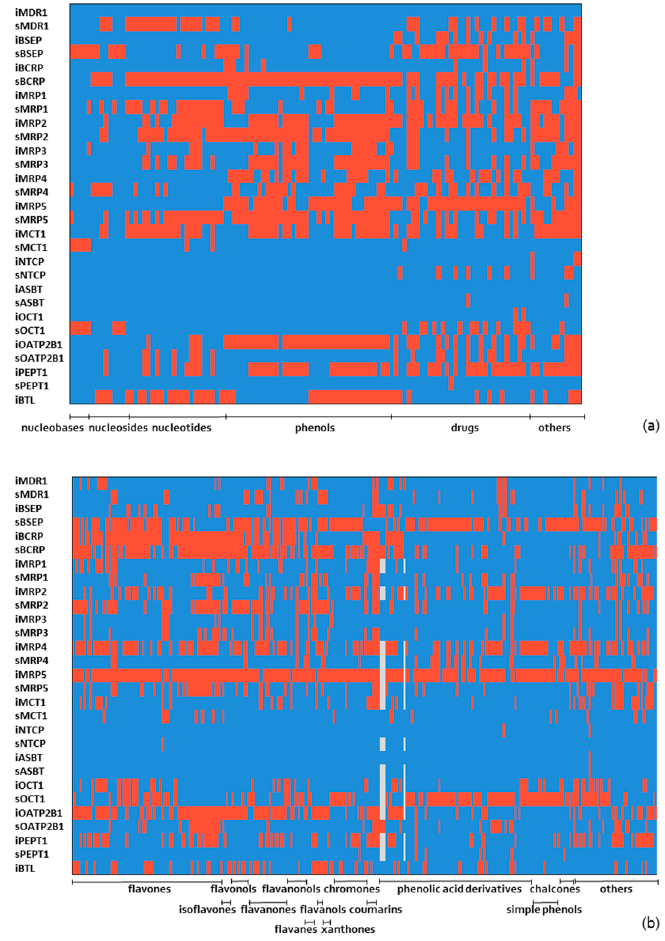
Figure 7. Activity profile of computational predictions for 14 transporters from ChemBench and for our BTL model, red— active, blue —inactive, grey —no prediction; ( a ) BTL dataset of 120 compounds, ( b ) phenols dataset of 300 compounds.